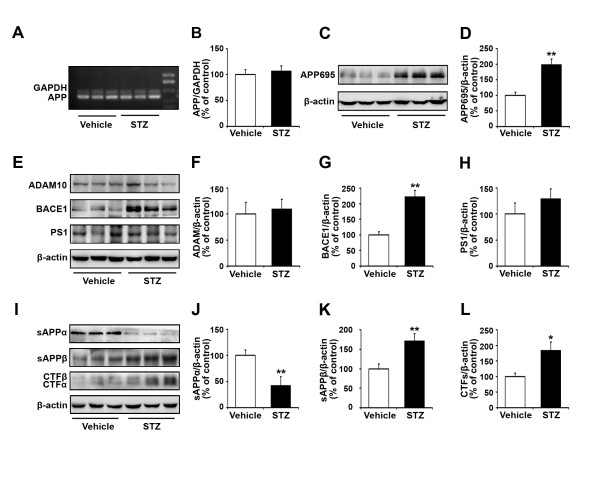
Expression levels of APP, cleavage enzymes and fragments of APP in STZ-treated transgenic mouse brain. (A) RT-PCR analysis was performed to determine the levels of APP mRNA in APP/PS1 transgenic mouse brain. GAPDH was used as an internal reference gene. (B) There were no significant differences in expression levels of APP mRNA between in the STZ- and vehicle-treated transgenic mouse brain. (C) Immunoblotting showing the expression levels of APP695 in vehicle control and STZ-treated APP/PS1 transgenic mouse brain. β-actin was used as a loading control. (D) Administration of STZ significantly increased the expression level of APP695 in the transgenic mouse brain. (E) Immunoblotting showing the expression levels of ADAM10, BACE1, PS1 in transgenic mouse brain. β-actin was used as a loading control. (F) STZ treatment did not affect the expression level of ADAM10 protein. (G) STZ-induced insulin deficiency resulted in a marked increase in BACE1 protein in the transgenic mouse brain. (H) STZ treatment resulted in an increased level of PS1 protein, but the difference was not statistically significant, compared with the vehicle control. (I) Immunoblotting showing the expression levels of sAPPα, sAPPβ and CTFs in transgenic mouse brain. β-actin was used as a loading control. (J) STZ-induced insulin deficiency significantly reduced the levels of sAPPα. (K) STZ treatment resulted in a markedly increased level of sAPPβ in transgenic mouse brain. (L) STZ treatment significantly increased the level of CTFs. *p < 0.05, **p < 0.01 (n = 7).